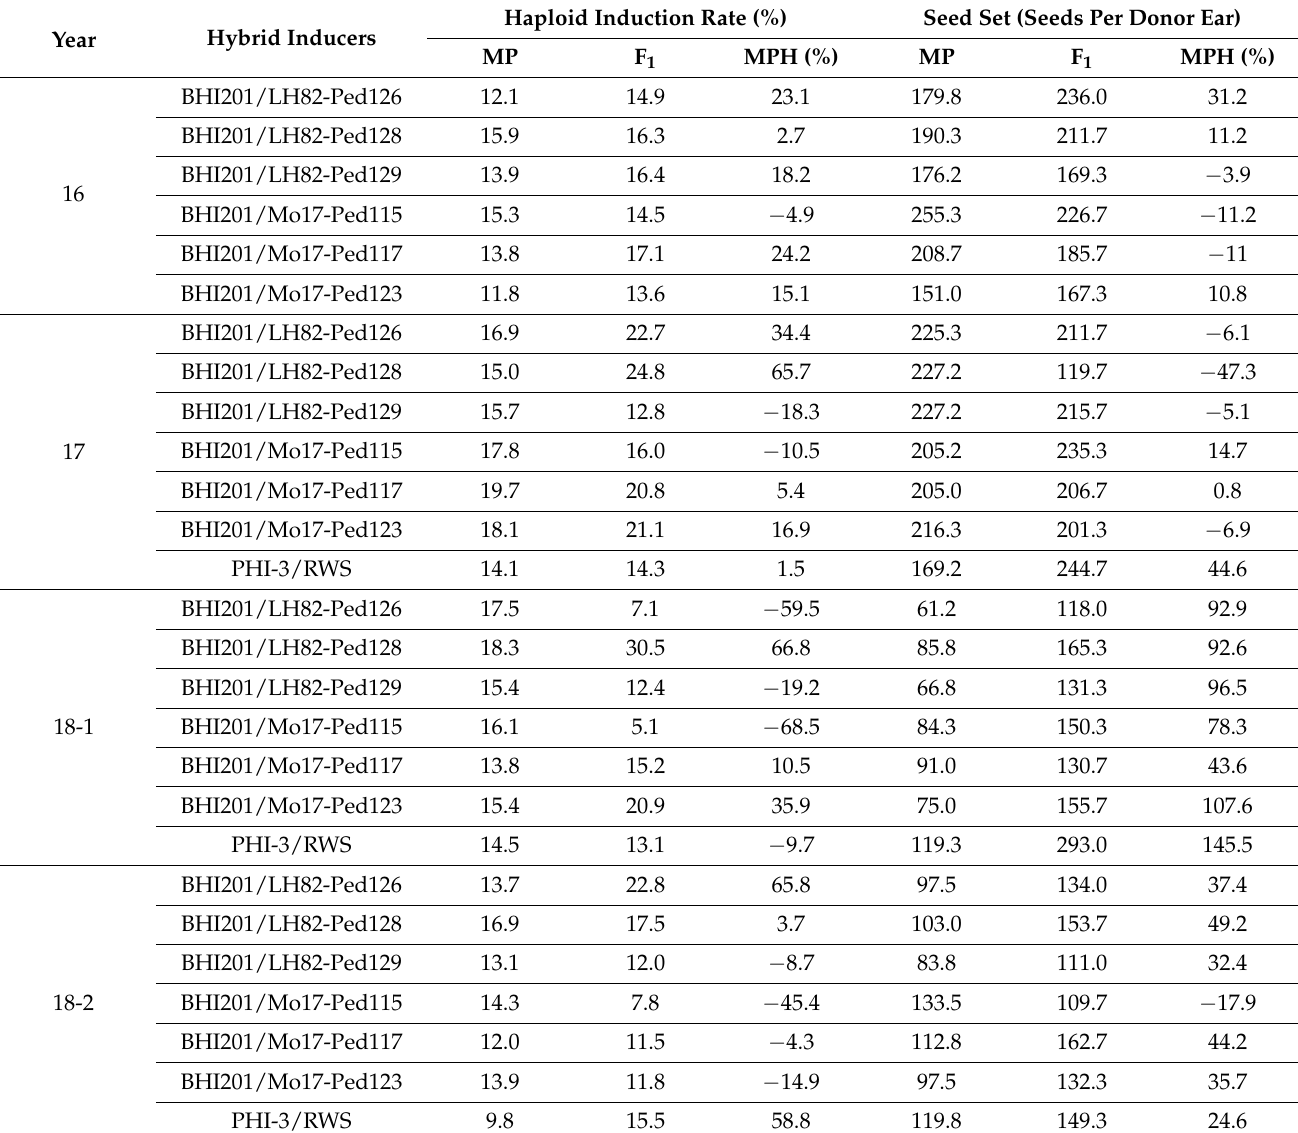
Table 2. Mid-parent (MP), hybrid mean (F1), and mid-parent heterosis (MPH) of hybrid haploid inducers on haploid induction rate (%) and seed set between 2016 and